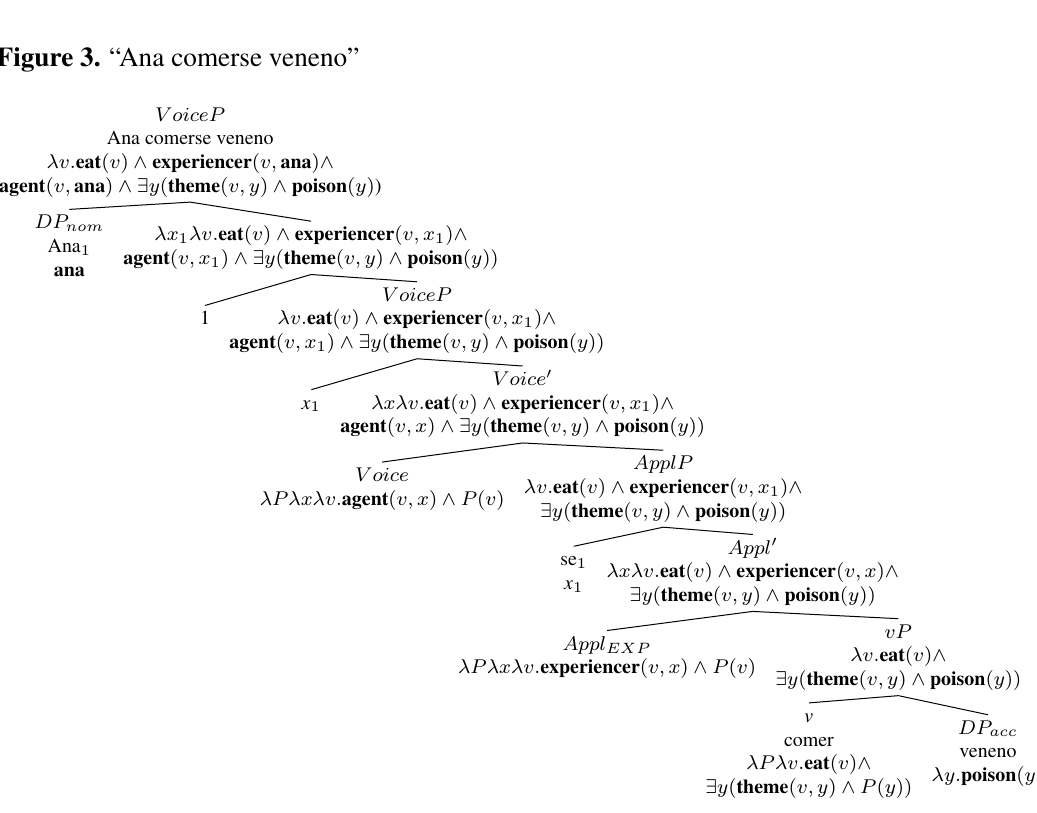
Figure 3. “Ana comerse veneno” V oiceP Ana comerse